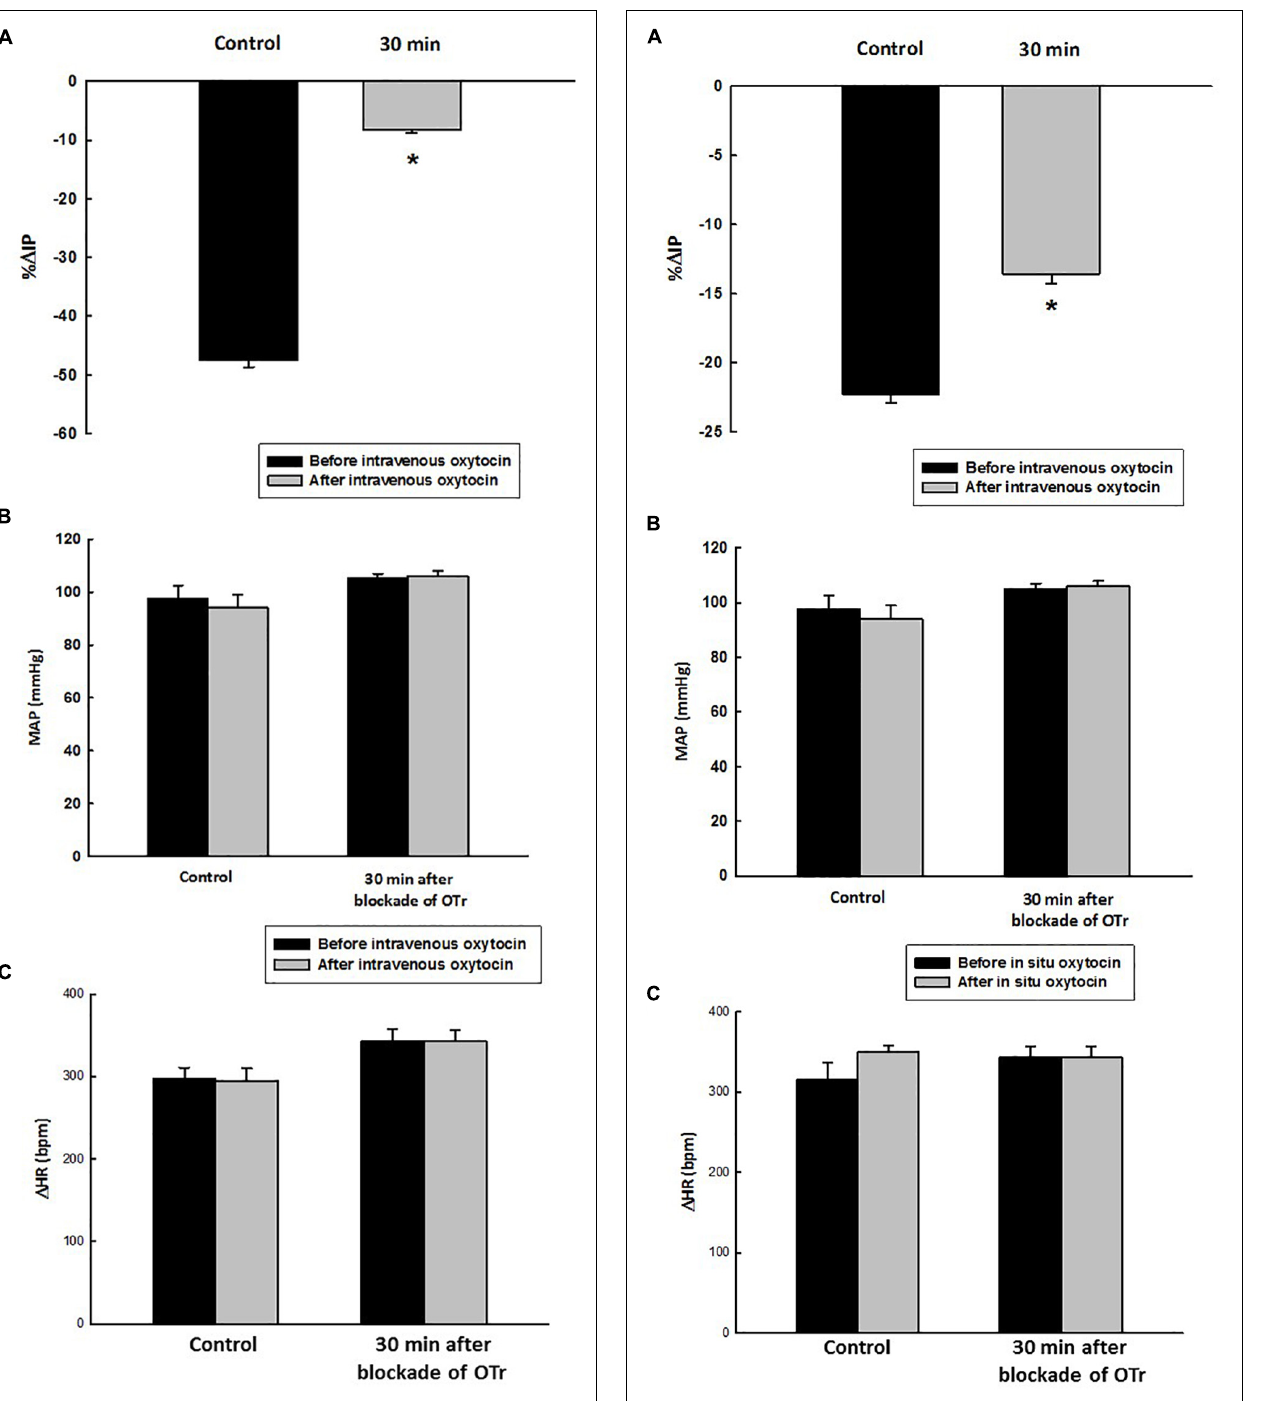
FIGURE 6 | Percent change in intravesical pressure ( A , % (cid:49) IP) evoked by intravenous injection of oxytocin dose (1.0 ng/kg of b.w., control response) and at 30 min after blockade of oxytocin receptors (OTr) (10 ug/kg, i.v.) in intact rats. Mean arterial pressure ( B , MAP, mmHg) and heart rate ( C , HR, bpm) at baseline and after intravenous injection of oxytocin dose (1.0 ng/kg of b.w., control response) and also at 30 min after blockade of oxytocin receptors (10 ug/kg, i.v.) in sham rats, * p < 0.05 vs. control ( N = 5).